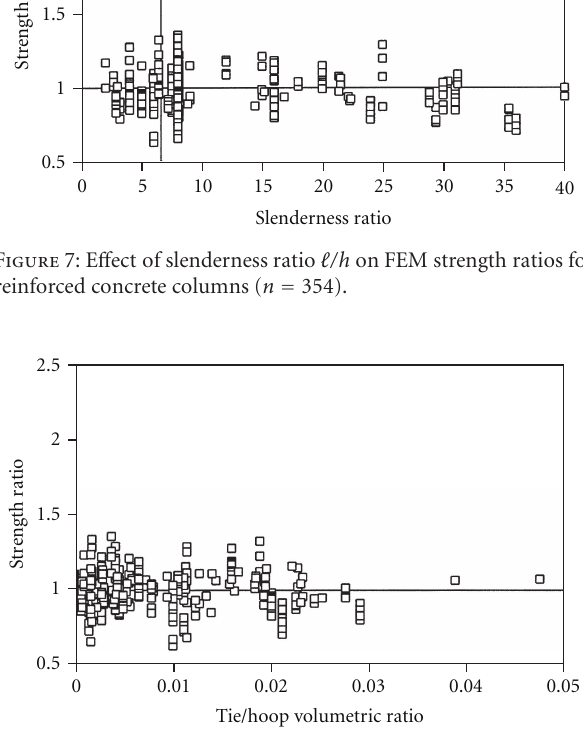
Figure 8: E ff ect of transverse reinforcement (tie/hoop) volumetric ratio ρ (cid:2)(cid:2) on FEM strength ratios for reinforced concrete columns ( n = 354).